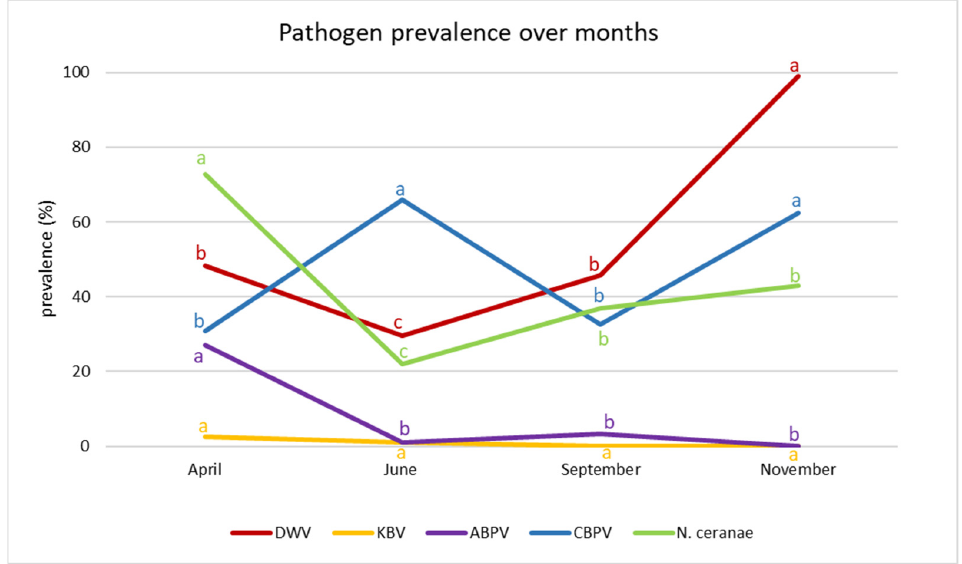
Figure 4. Pathogen prevalence over months. Different letters denote significant differences in the prevalence of individual pathogens.